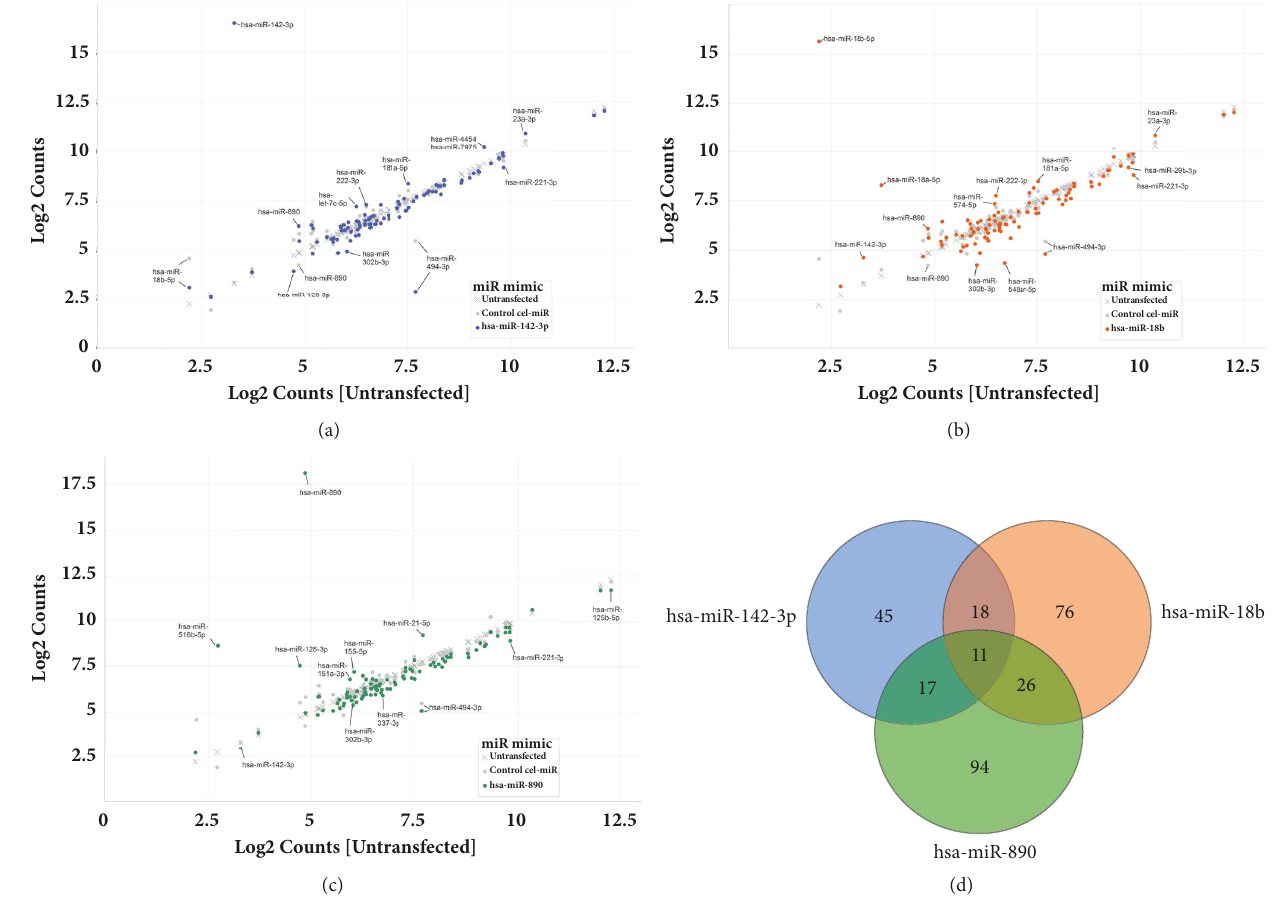
Figure 1: (a-c) Global alterations in colorectal cell miR levels in human epithelial CRL-1790 cells transfected with control cel-miR or MetS-FL miR mimics. (d) Common miR targets whose expression levels were altered by 2.0-fold or more following CRL-1790 cell transfection with each MetS-FL miR mimic. Eleven common miRs targeted by all three MetS-FL miRs are listed in Table